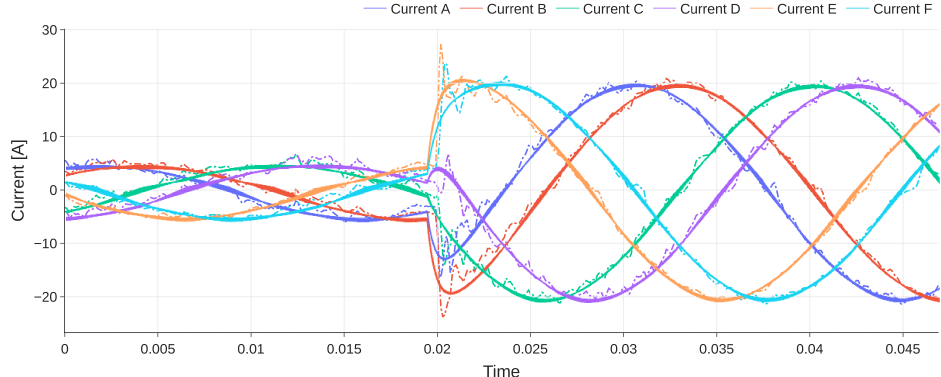
Figure 5. Comparison between experimental data (dashed line) and simulation results (solid line).